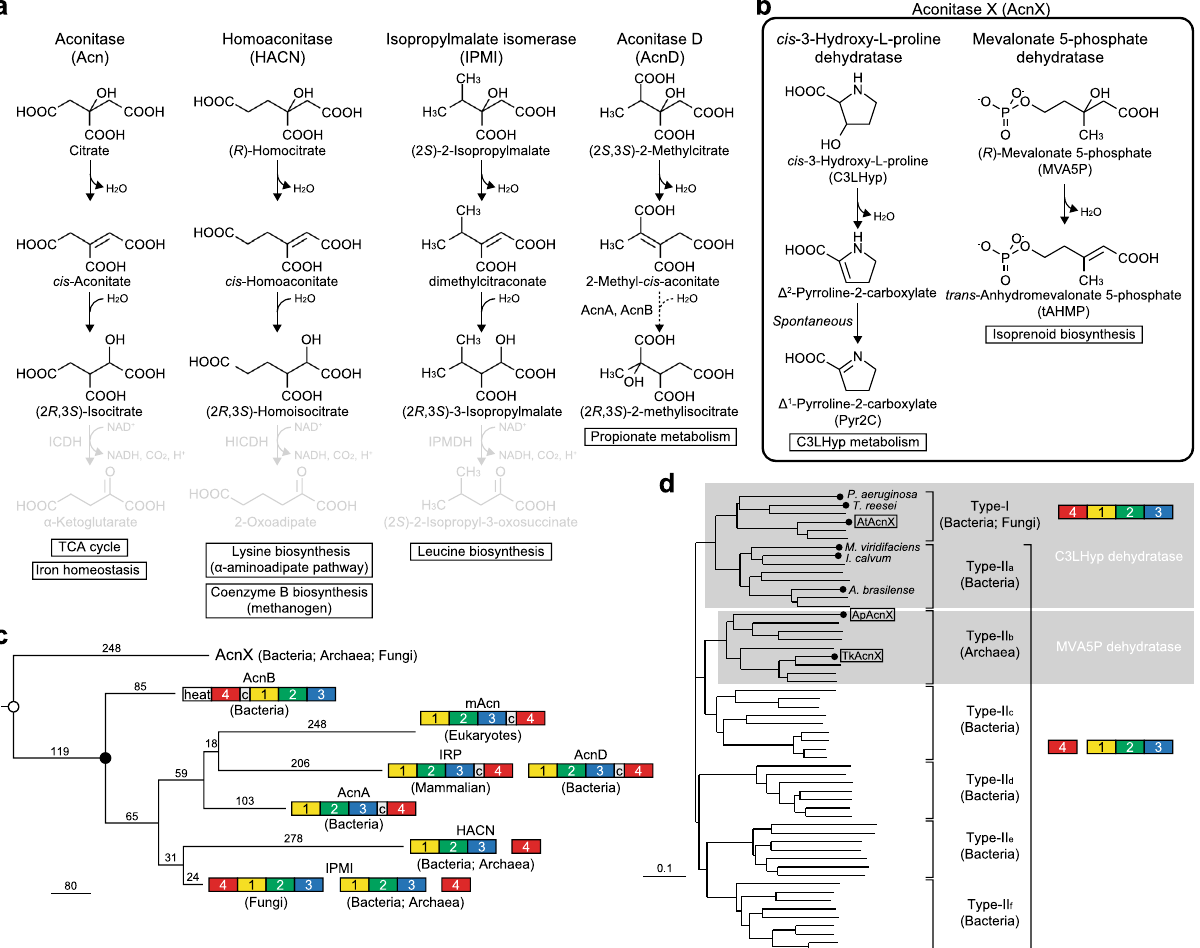
Fig. 1 Aconitase superfamily members. Schematic reactions of four known functional members of the aconitase superfamily ( a ) and two functional members of the AcnX subfamily ( b ) . Each physiological role is in a box. In propionate metabolism, AcnD catalyzes only the dehydration of (2 S ,3 S )-2- methylcitrate to 2-methyl- cis -acotinate, which is subsequently metabolized to (2 S ,3 R )-2-methylisocitrate by either AcnA and AcnB. c Phylogenetic tree of the aconitase superfamily. A linear representation of the sequential domain arrangement of eight phylogenetic subfamilies is also included. “ c ” is the connector domain and “ heat ” is a protein – protein interaction domain found only in AcnB 2 . This phylogenetic tree was constructed based on the sequence identity of domain 4, in the National Center for Biotechnology Information (NCBI). The closed circle indicates the common ancestor for other aconitase enzymes that had previously been proposed, which contains the [4Fe-4S] cluster. The open circle indicates the common ancestor for the aconitase superfamily that is proposed in the present study. d Phylogenetic tree of the AcnX subfamily based on sequence similarity. The AcnX subfamily is further classi fi ed into AcnX Type-I , consisting of a single polypeptide from bacteria and fungi, and AcnX Type-II in a number of bacteria (AcnX Type-IIa , AcnX Type-IIc AcnX Type-IIf ) and archaea (AcnX Type-IIb ), which consists of (fragmented) small and large polypeptide chains. Among them, AcnX Type-I and AcnX Type-IIa , and AcnX Type-IIb correspond to C3LHyp dehydratase and MVA5P dehydratase, respectively, in Fig. 1b. The circles at the end of each branch are the enzymes that have been functionally characterized. The large subunit of AcnX Type-II was used for this phylogenetic analysis. A more-detailed comparison is shown in Supplementary Fig.